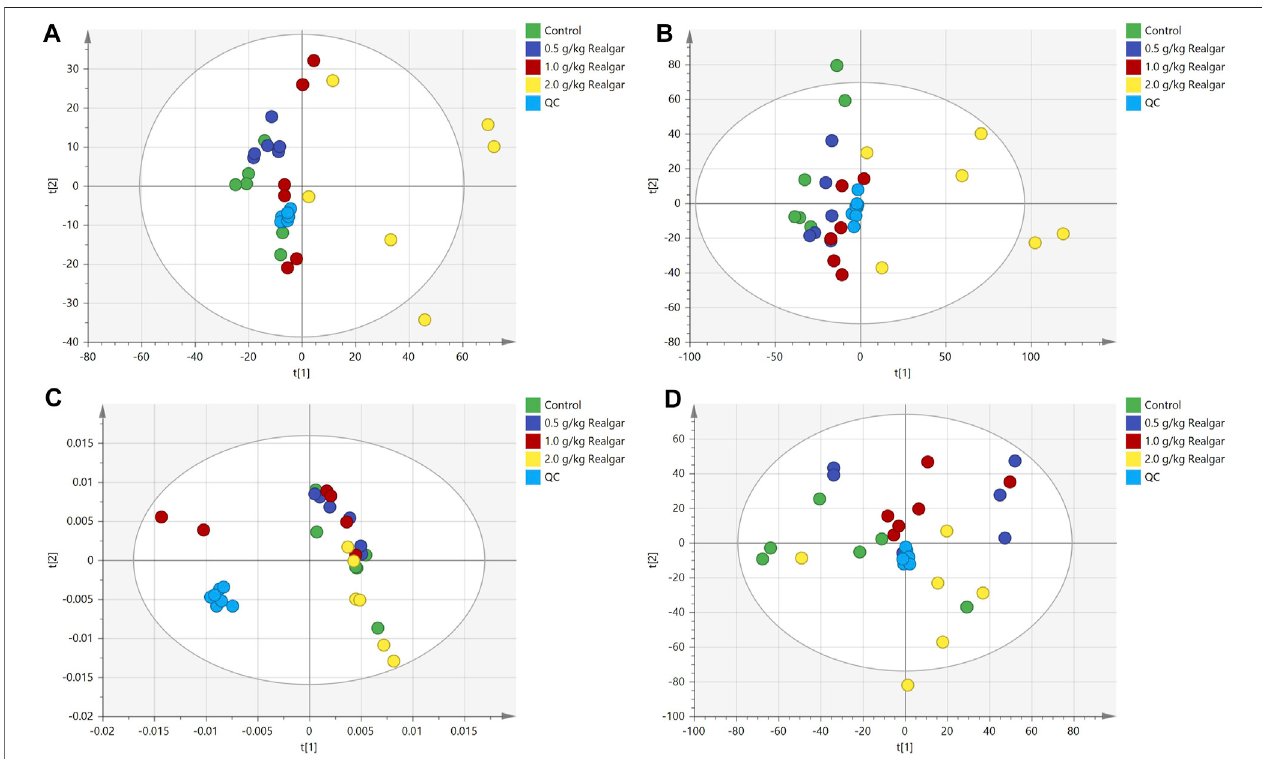
FIGURE2| ScoringplotsofPCAanalysis[ (AandB) ofthepositiveandnegativeionmodesofserum samples,respectively; (CandD) ofthepositiveand negative ion modes of the kidney samples, respectively] models with the statistical parameters as follows: (A) R2X (cid:2) 0.495, Q2 (cid:2) 0.138; (B) R2X (cid:2) 0.388, R2Y (cid:2) 0.841, Q2 (cid:2) 0.530; (C) R2X (cid:2) 0.525, Q2 (cid:2) 0.207; (D) R2X (cid:2) 0.391, R2Y (cid:2) 0.867, Q2 (cid:2)